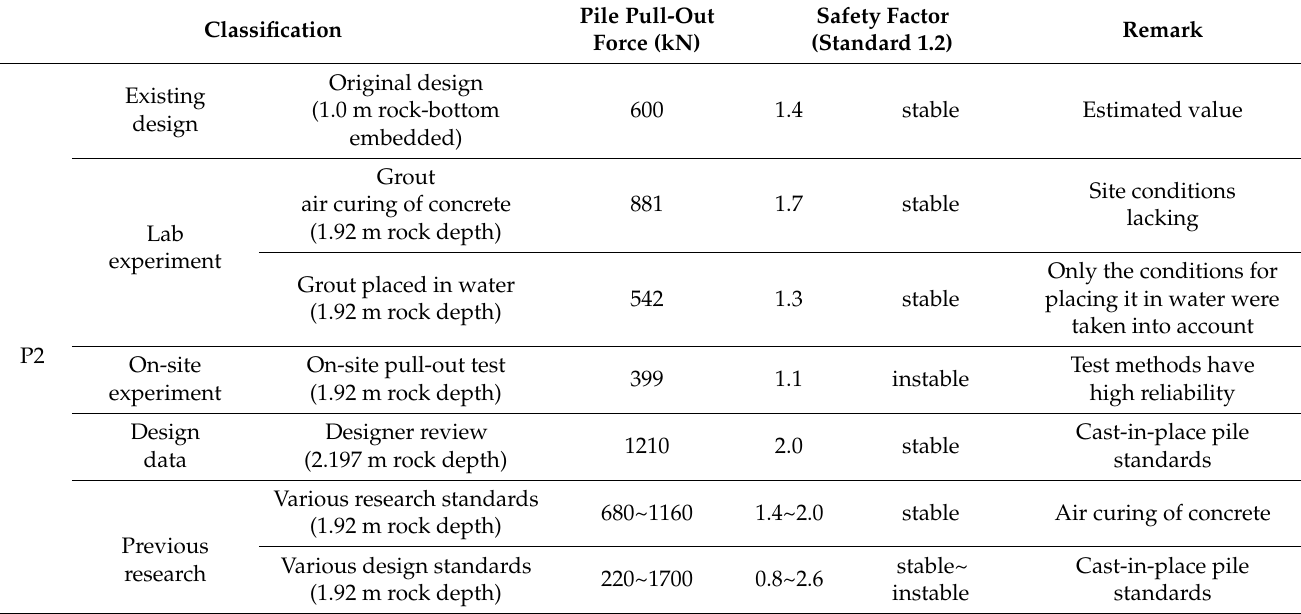
Table 8. Results of C.T cofferdam stability review according to the recalculation of the pull-out force.